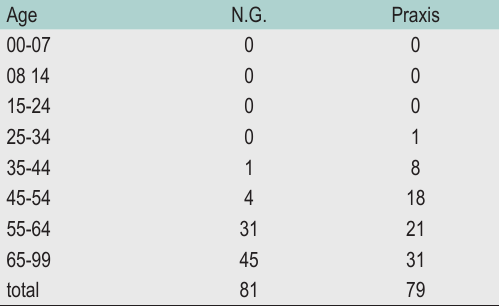
TABLE 4. Presentation of respondents with bilateral gonar- throsis by age group in clinics D.Z. “Novi Grad” and "Praxis".